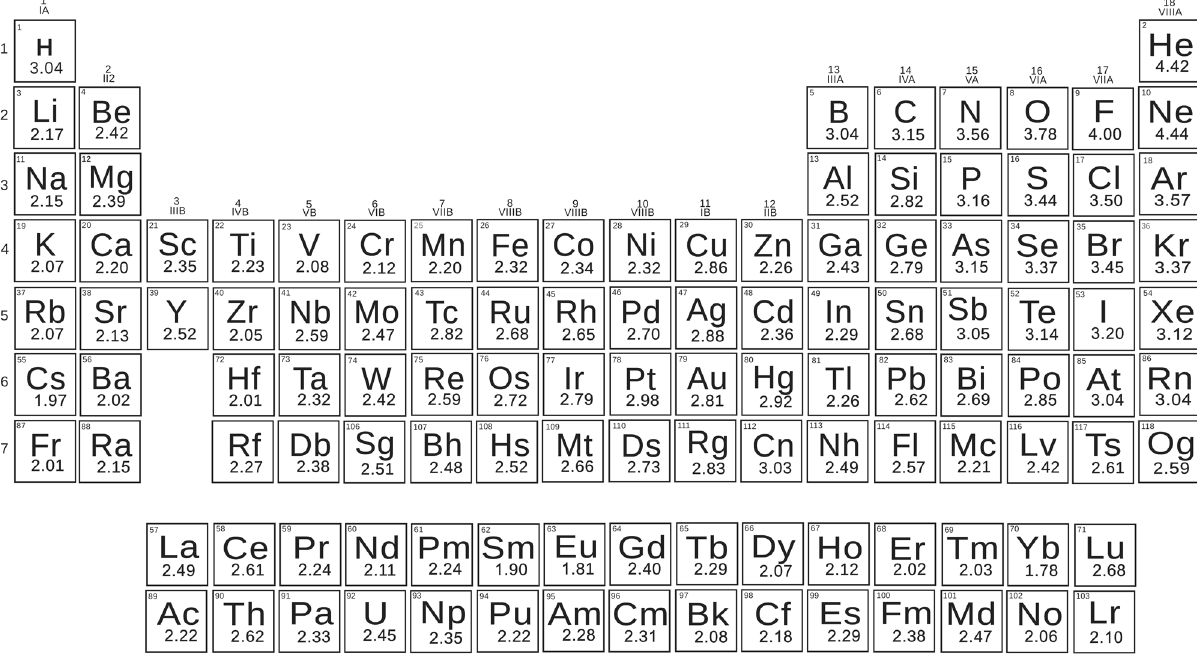
Fig. 1 Periodic Table of our thermochemical electronegativities. Electronegativities were obtained using the formula D AB ¼ D cov where D AB is the dissociation energy of chemical bond between two different atoms A and B, D cov arithmetic mean of the homonuclear dissociation energies and Δ X 2 The electronegativity values of the elements are also provided as Supplementary Data